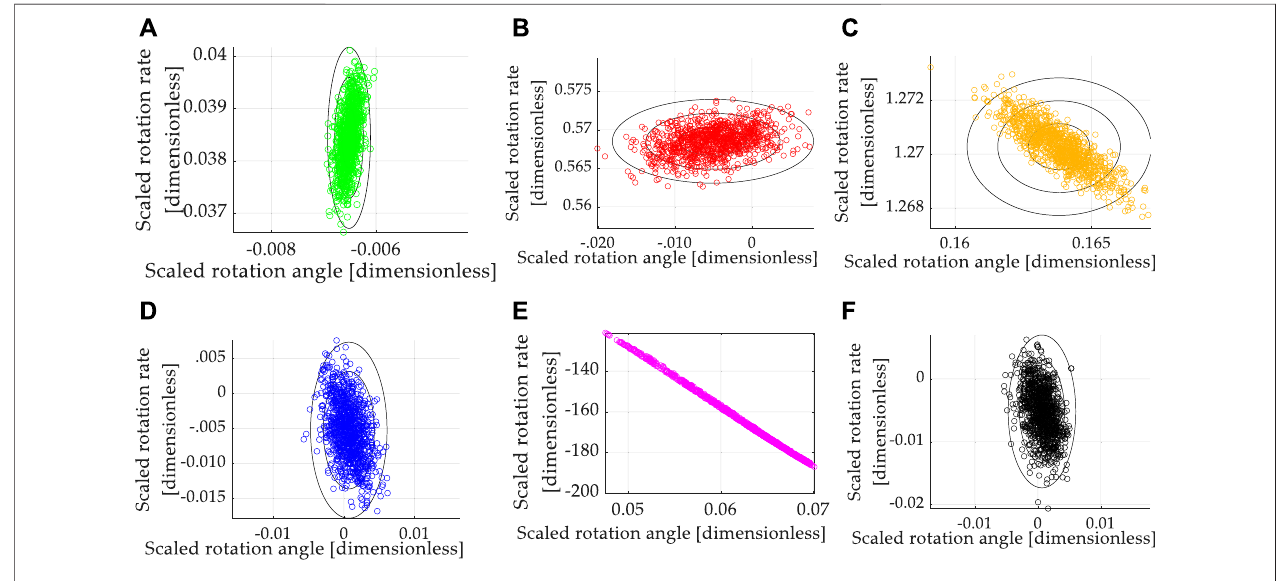
FIGURE 2 | Scatter plots displaying the results of 1,000 simulation runs (per case) with randomly (uniformly) varied mass and mass moments ± 10%. (A) classical P + V, (B) LQR optimal PD, (C) time-optimal control, (D) open-loop optimal, (E) real-time optimal (RTOC), and (F) switched RTOC.